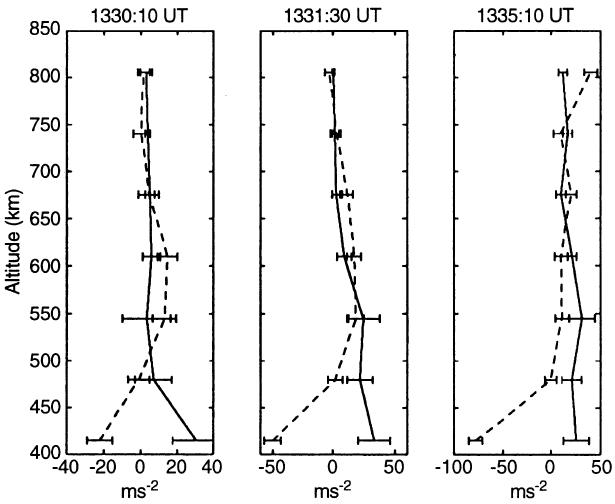
Fig. 7. Calculated momentum terms at three di(cid:128)erent times 1330:00 UT, 1331:30 UT and 1335:10 UT. The solid lines represent the advection combined with the ion-neutral collisional term. The dashed line is the combination of the pressure gradients and the gravitational